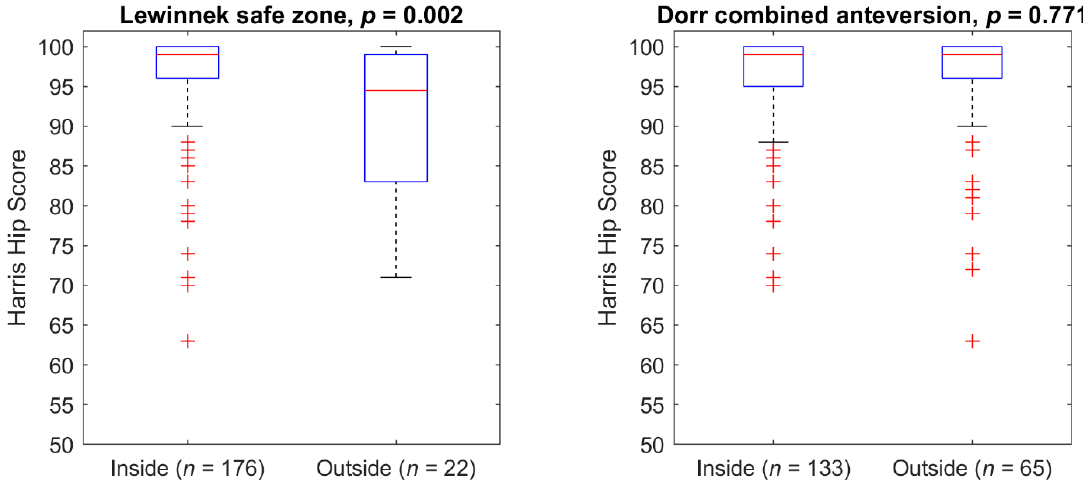
Figure 9. The HHS of the patients divided by the conventional target zones.